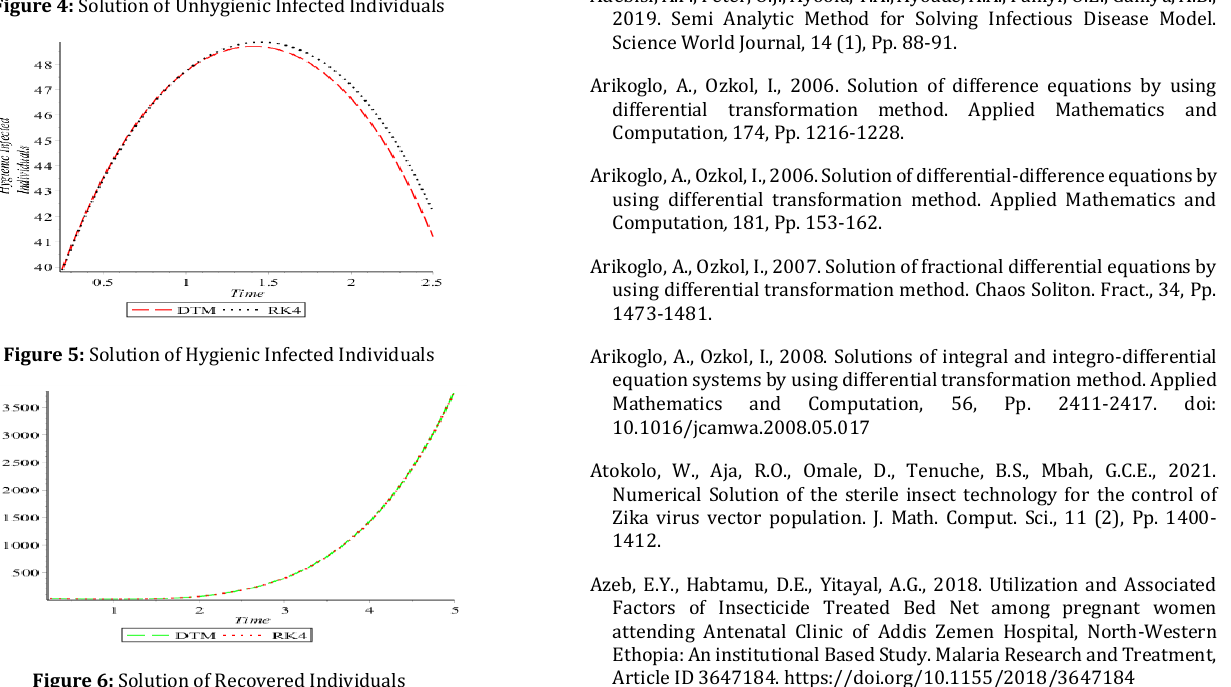
Figure 6: Solution of Recovered Individuals